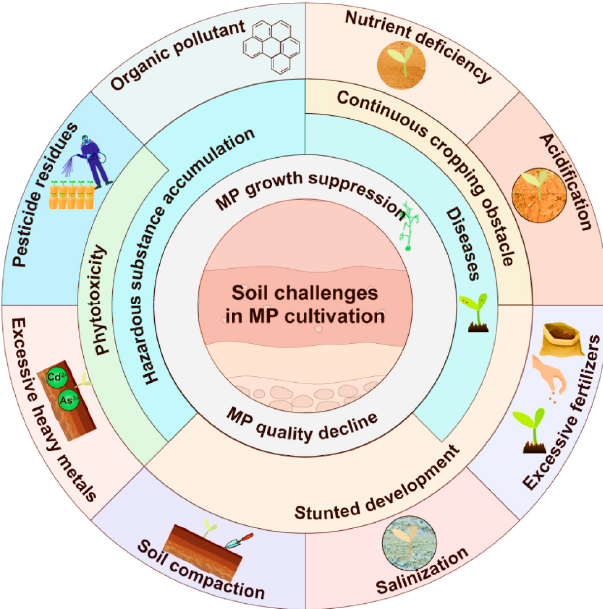
Figure 2. Main soil challenges and their negative effects in the cultivation of medicinal plants. Nutrient deficiency and imbalance, soil compaction, salinization and acidification retard the growth and development of MPs, accompanied by continuous cropping obstacles. The harmful substances, including chemical pesticides, heavy metals and organic pollutants in soil, can cause phytotoxicity, and they are absorbed and accumulated by MPs, posing serious health risks to consumers through the food chain.